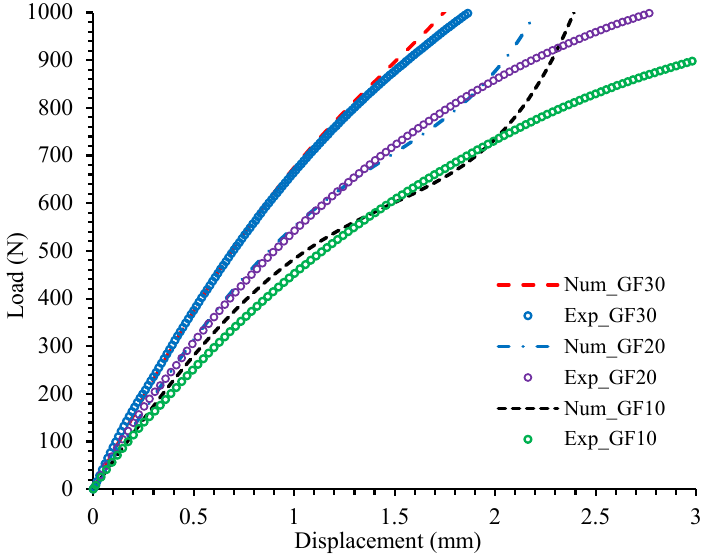
Figure 3. Load-displacement curves of tensile tests on PA66GFs: transverse direction.